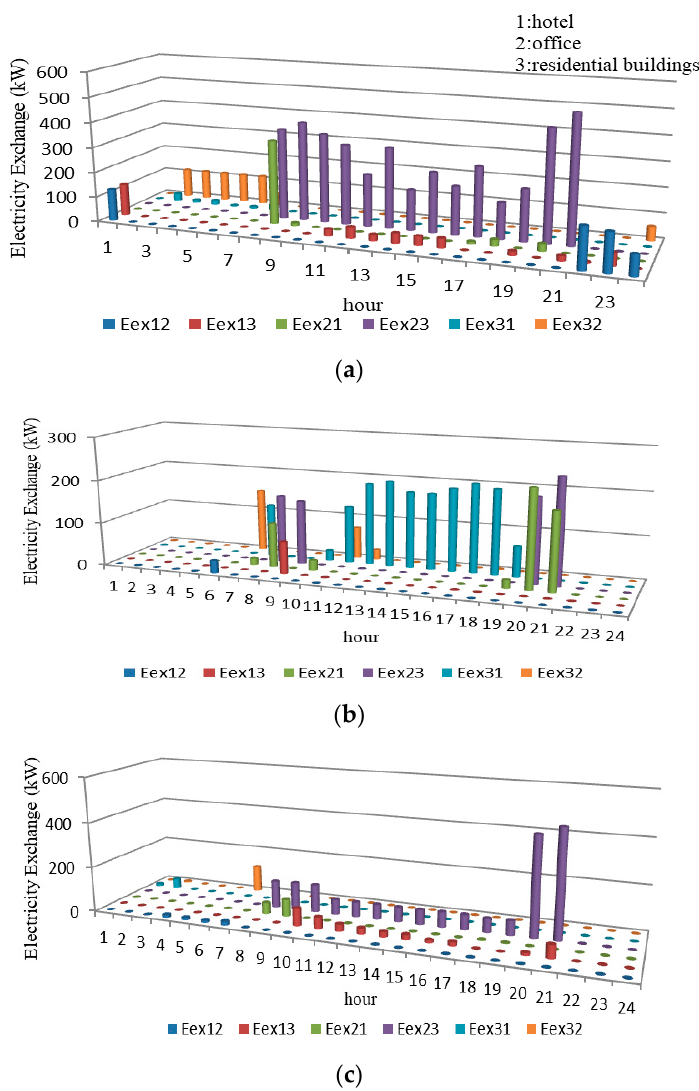
Figure 5. Optimal electricity interchange of buildings in typical winter ( a ), summer ( b ) and mid-season days ( c